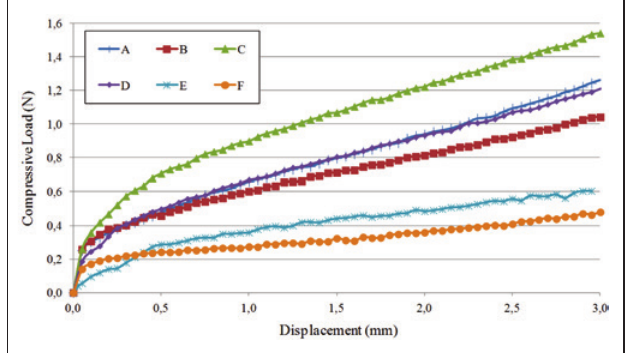
Figure 5 – Curve shape of load versus displacement of adhesive mortars, obtained with the Squeeze Flow test